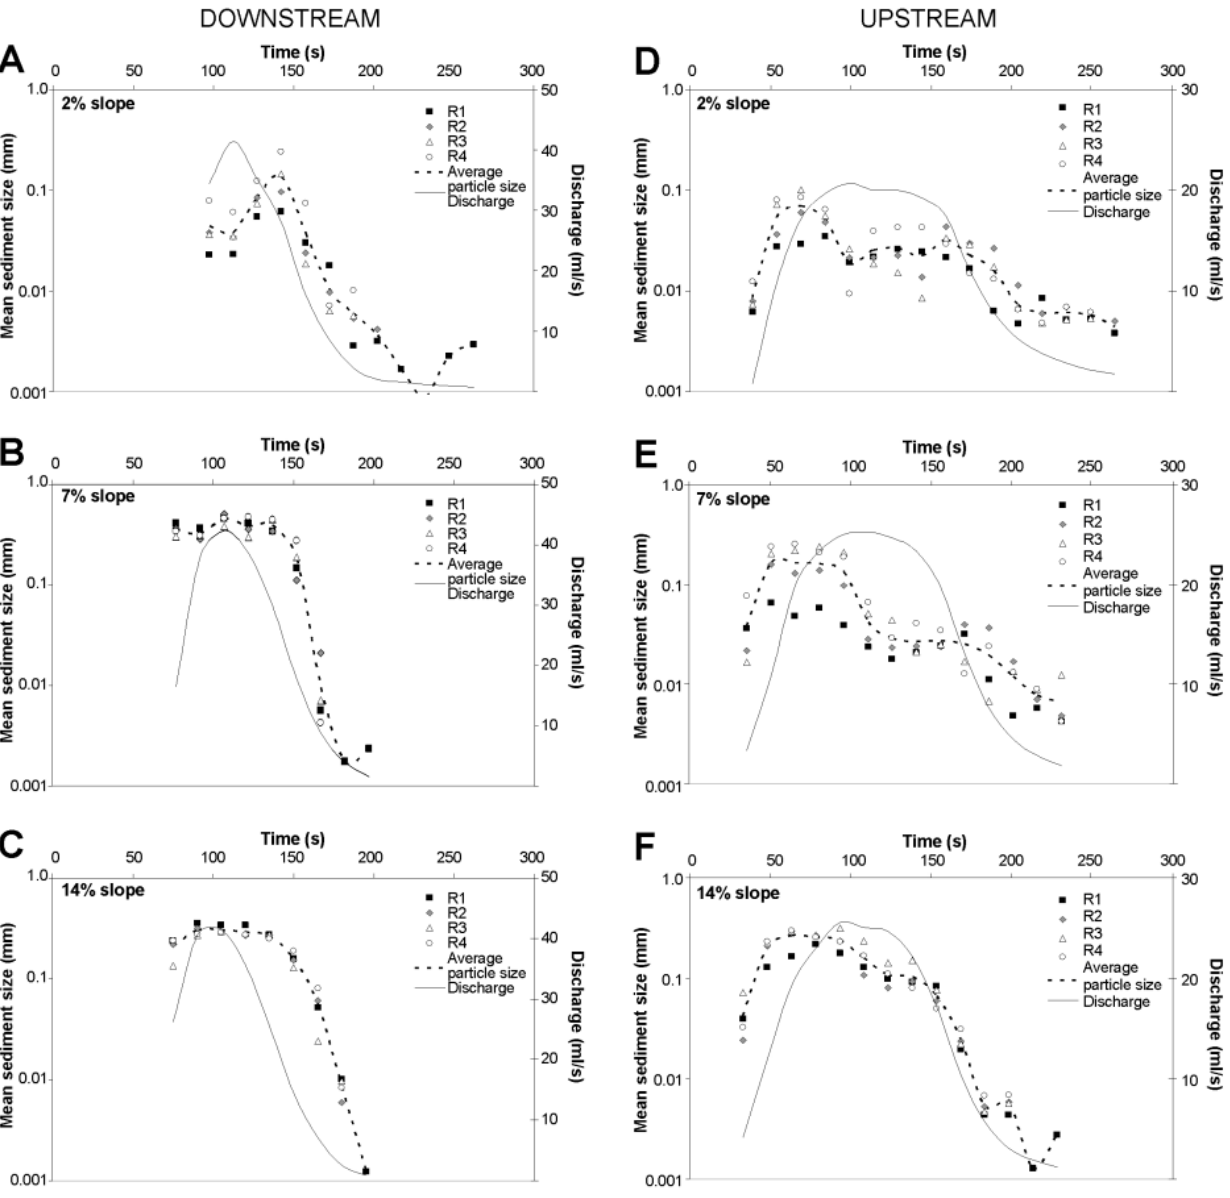
Fig. 5. Evolution over time of mean grain-size of transported sediments and runoff discharge, during each laboratory run, for storms moving downstream (left) and upstream (right) for surface gradients of 2%, 7%, and 14%. Grain-size data are for four independent repetitions (R1, R2, R3, and R4); broken line represents the regression line through these four repetitions.